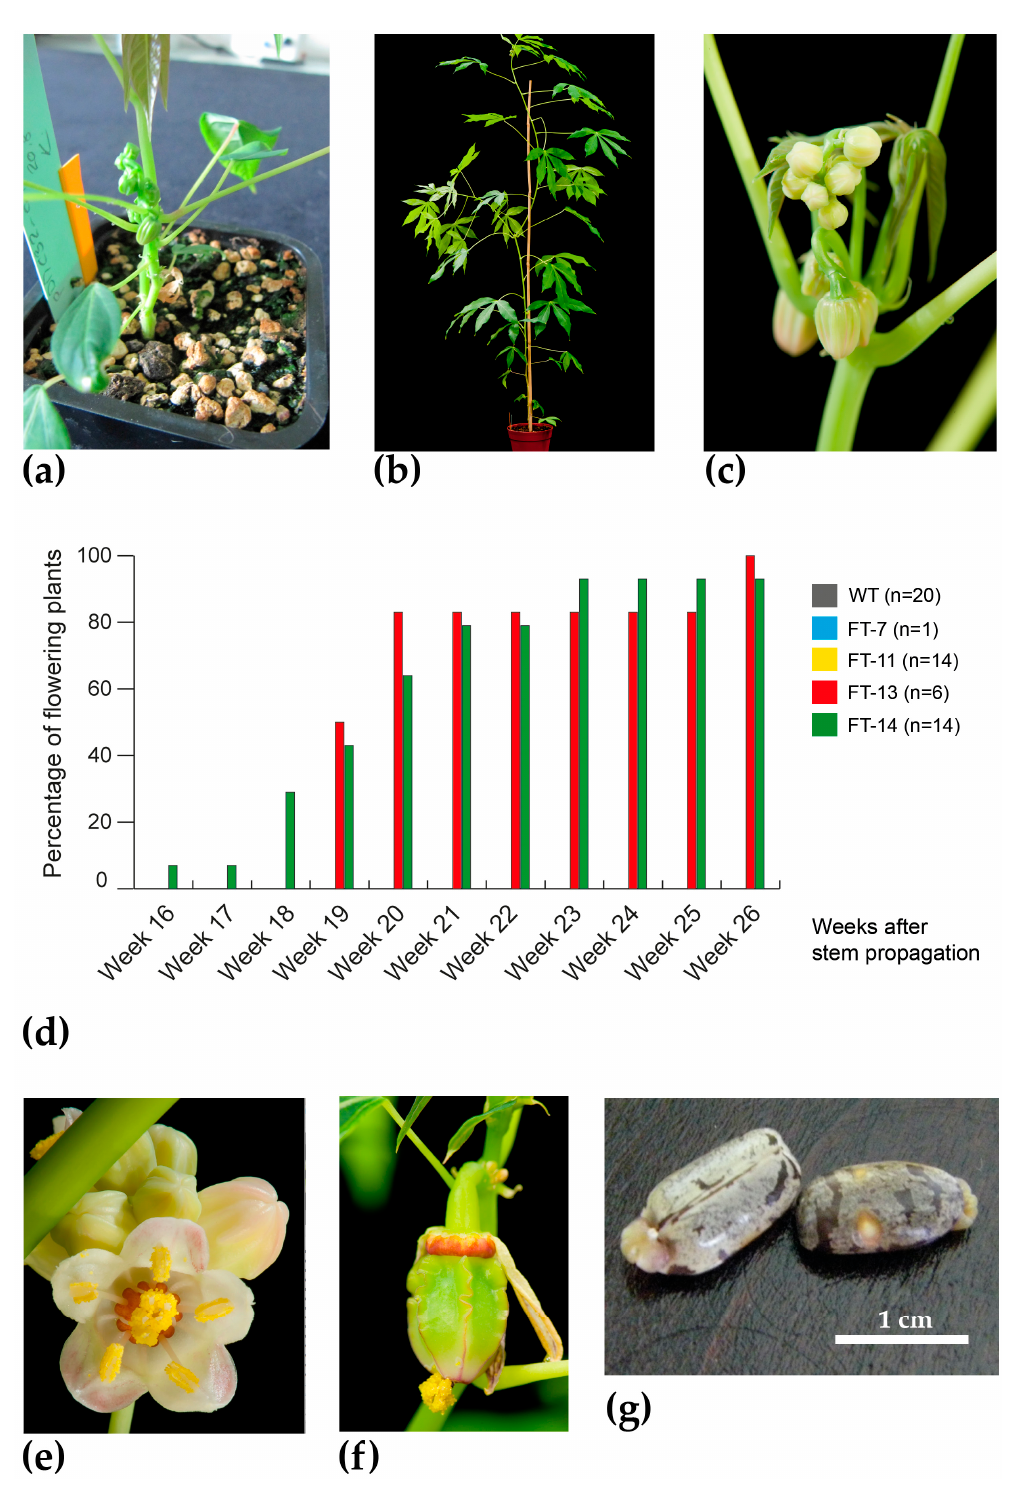
Figure 1. Early flowering in glasshouse-cultivated cassava. ( a ) FT-14 plant with flower buds evident after six weeks of growth in soil. ( b ) FT-13 plant at five months of growth; and ( c ) enlarged image showing pistillate and staminate buds on a branch. ( d ) Percentage of flowering plants per line following stem propagation. ( e ) Staminate flower from transgenic line FT-13. ( f ) Seed capsule developing after manual pollination of a pistillate flower with pollen of transgenic line FT-13 (selfing). ( g ) Harvested cassava seed resulting from manual pollination. Glasshouse conditions were 26 °C, 60% humidity and 14 h photoperiod with supplementary lighting.